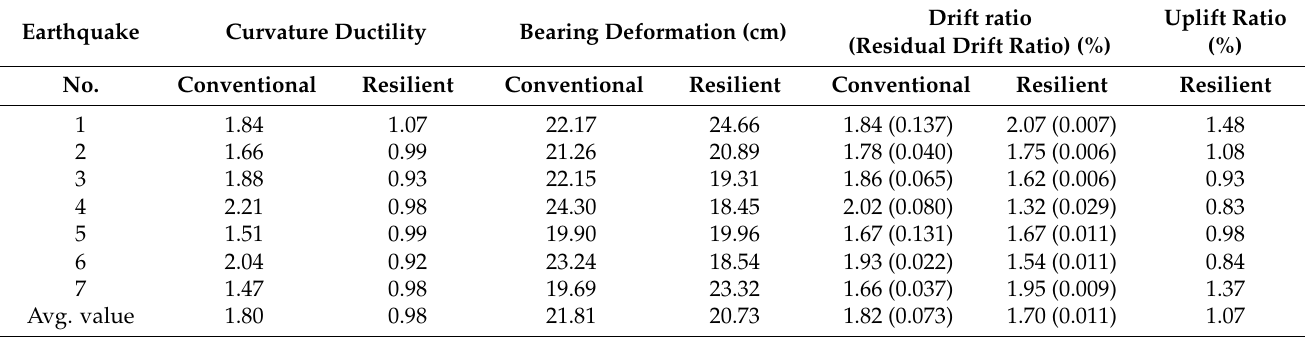
Table 4. Maximum seismic responses of ECC-reinforced bridges at E2